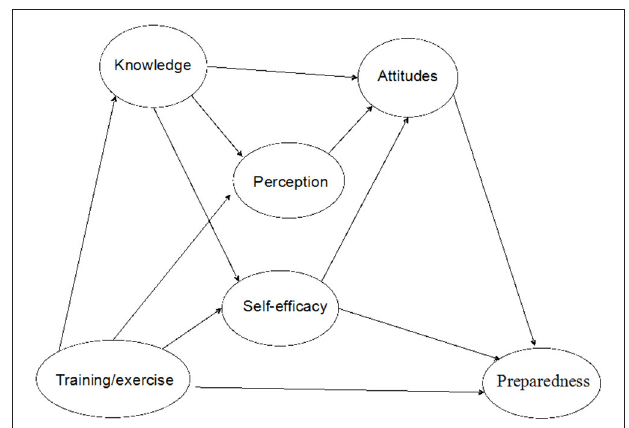
FIGURE 1 | Theoretical model for emergency preparedness